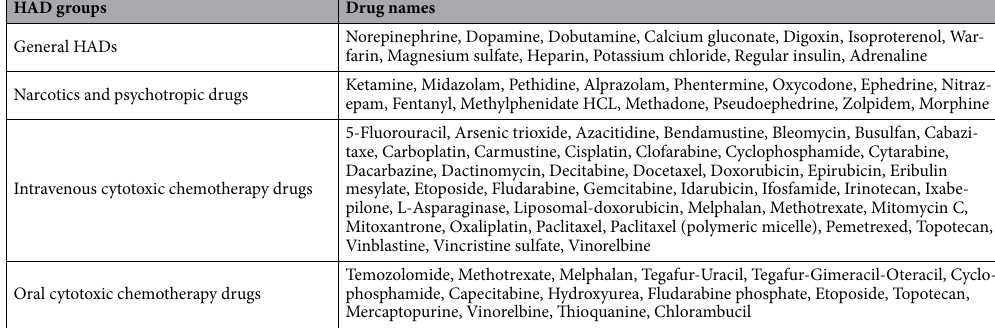
Table 2. High alert drug (HAD) groups.